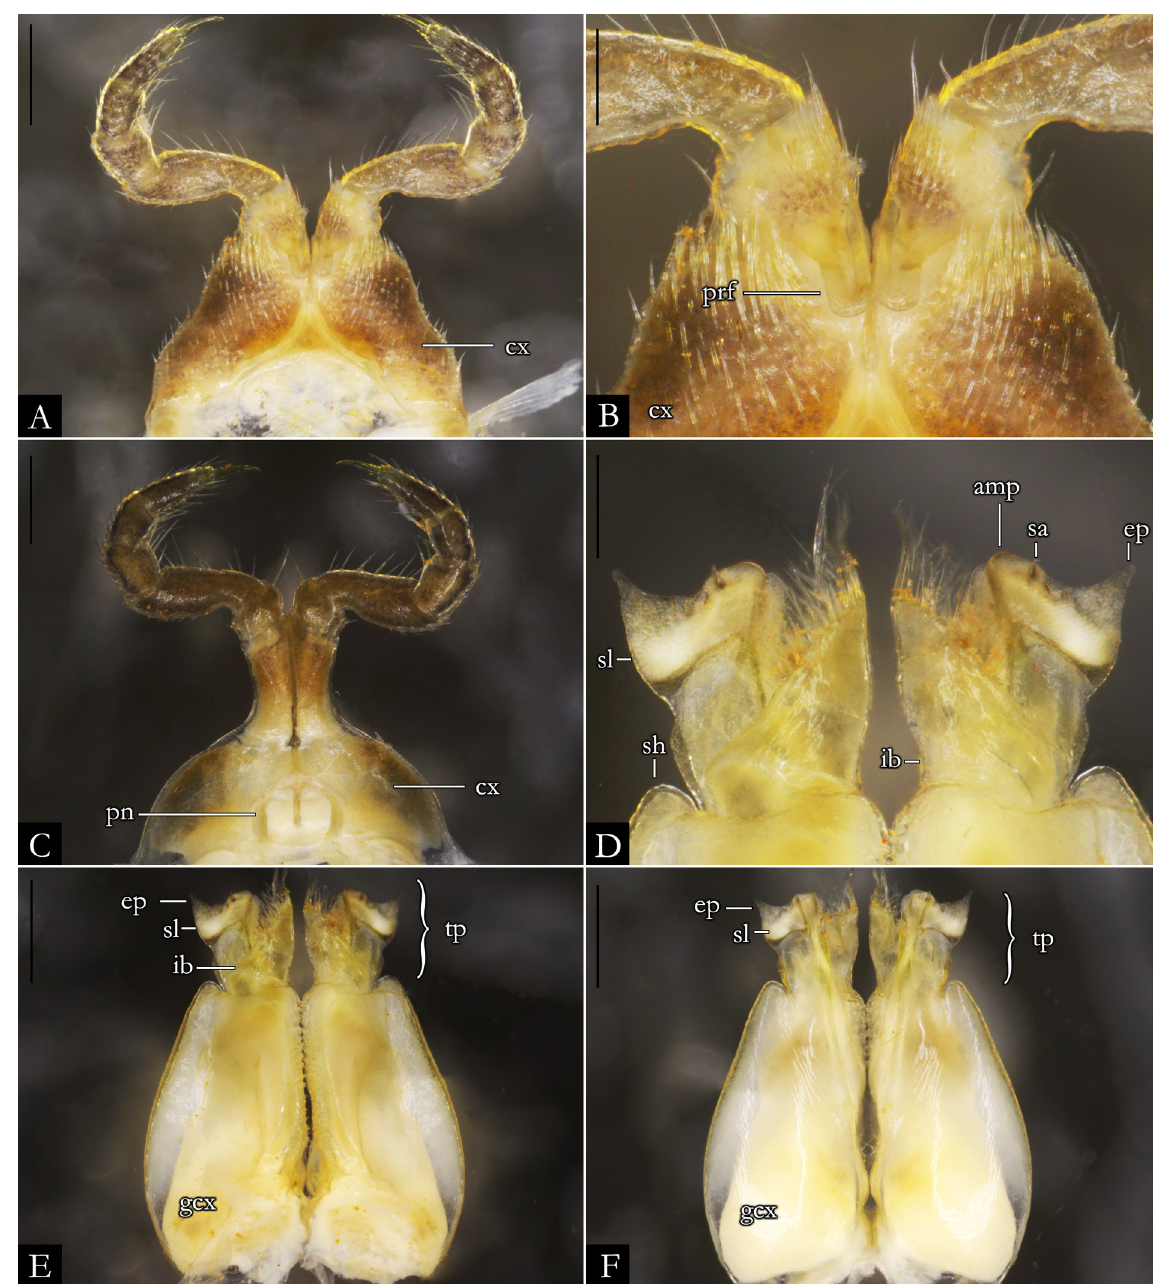
Fig. 118. Pseudonannolene rolamossa Iniesta & Ferreira, 2013, ♂ (ISLA 15054). A . First leg-pair. B . Detail of prefemur. C . Second leg-pair. D . Detail of telopodites, in anal view. E . Gonopods, in anal view. F . Gonopods, in oral view. Abbreviations: see Material and methods. Scale bars: A, C, E–F = 0.5 mm; B, D = 0.2